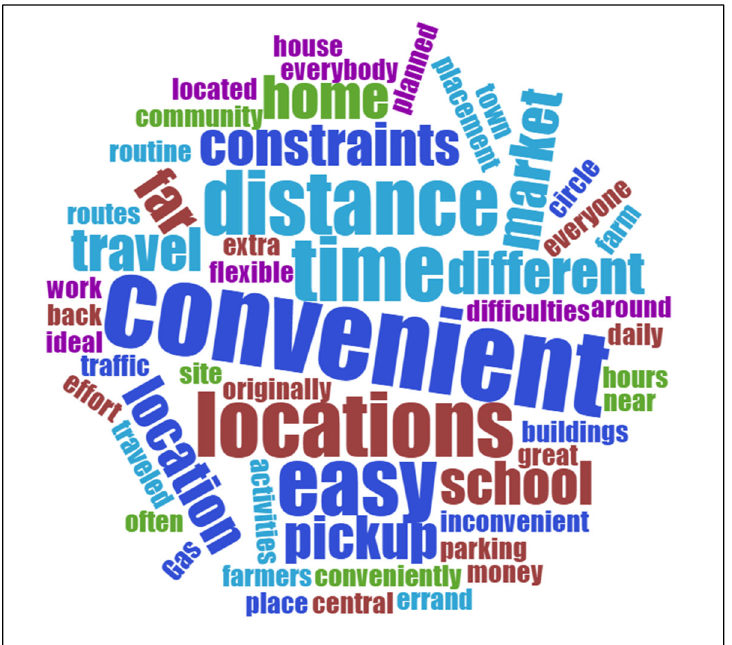
Figure 5. Word Cloud Summary of Customer